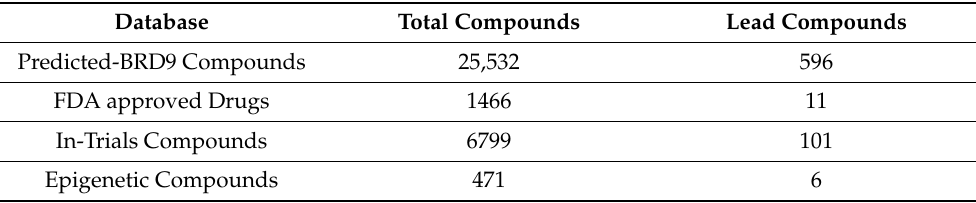
Table 2. Pharmacophore-based virtual screening hits obtained from each subset of the ZINC data-